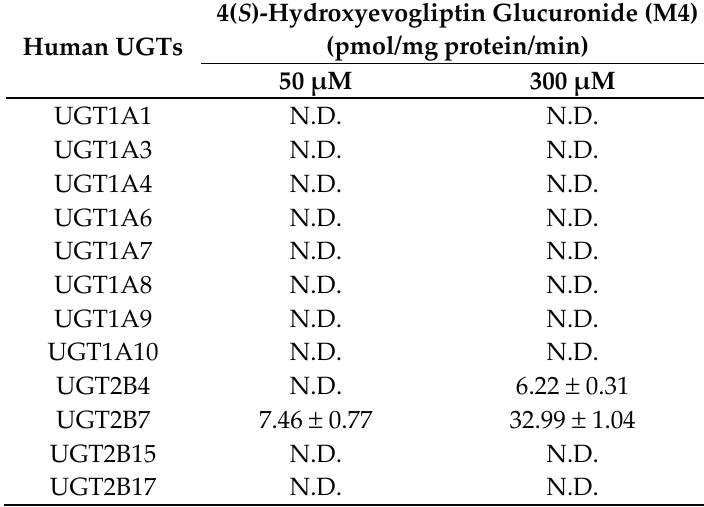
Table 4. Formation rates of 4( S )-hydroxyevogliptin glucuronide (M4) from 50 and 300 μ M 4( S )-hydroxyevogliptin (M2) in human cDNA-expressed UGTs (mean ± SD, n =